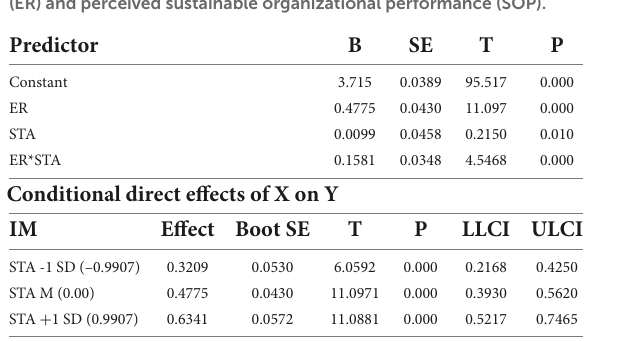
TABLE 8 Results of moderated regression analyses for sustainable tourism attitude (STA) as a moderator between employee resilience (ER) and perceived sustainable organizational performance (SOP).